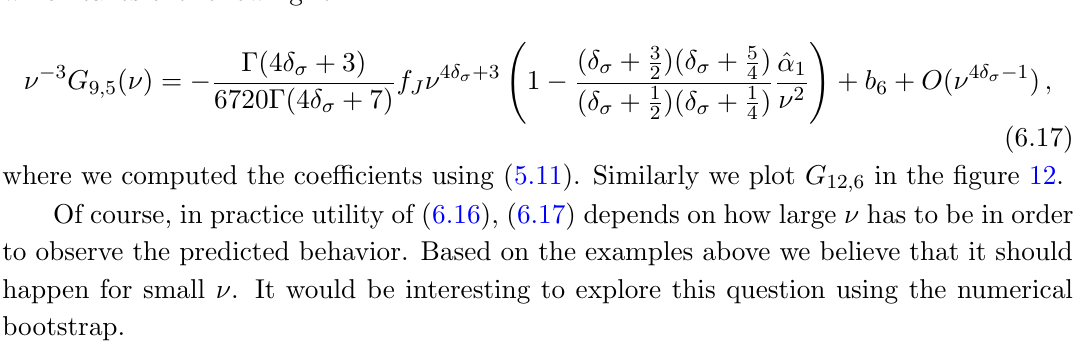
> 1 the (cid:12)rst subleading universal term "